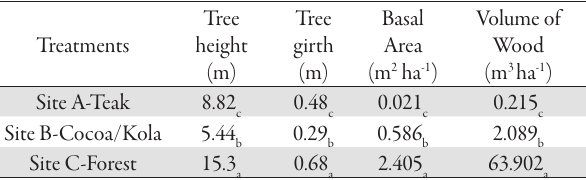
Tab. 2. Mean values of vegetation parameters in the study sites Treatments